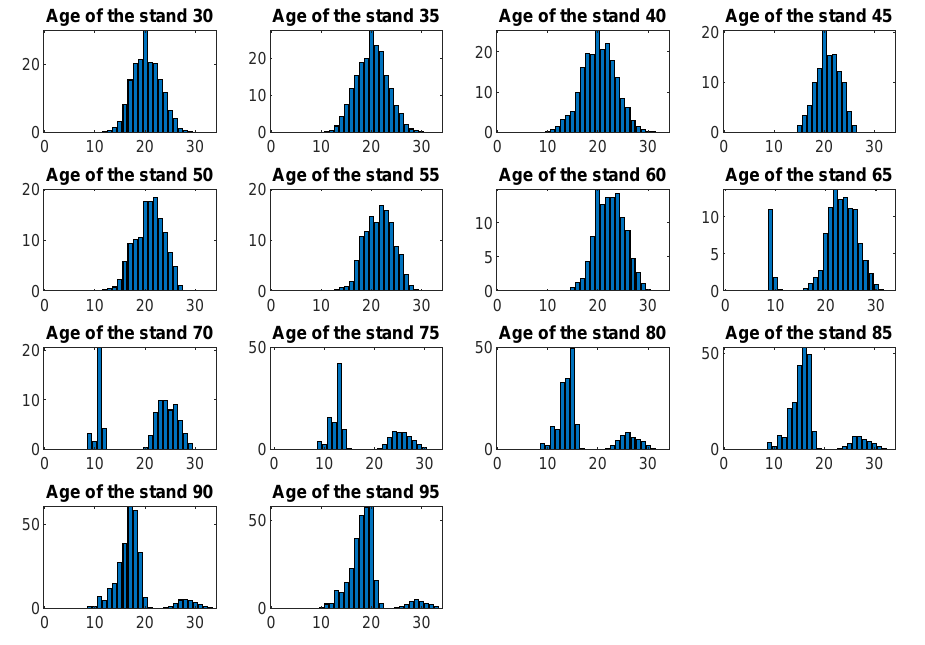
Figure 2. Height variation in diameter class 14–17 cm evolving in time, when stand management is optimized with 3% discount rate. On y -axis is number of stems (per hectare) and on x -axis height (in meters,